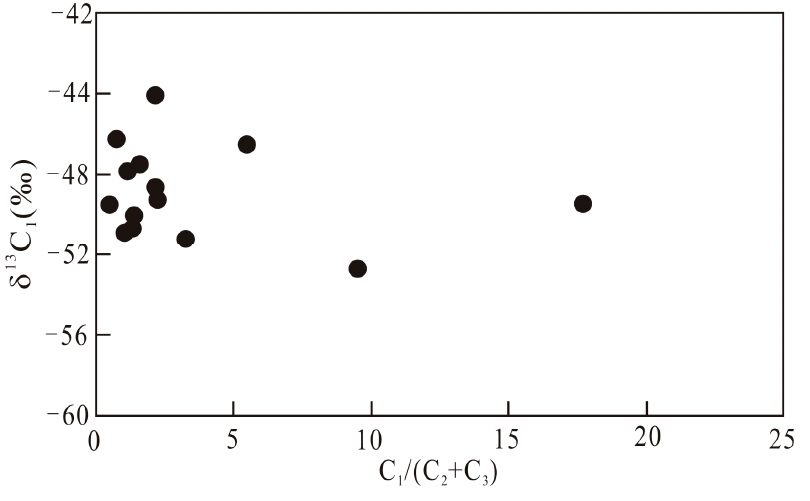
Figure 5. Cross plots of C 1 /(C 2 +C 3 ) vs δ 13 C 1.